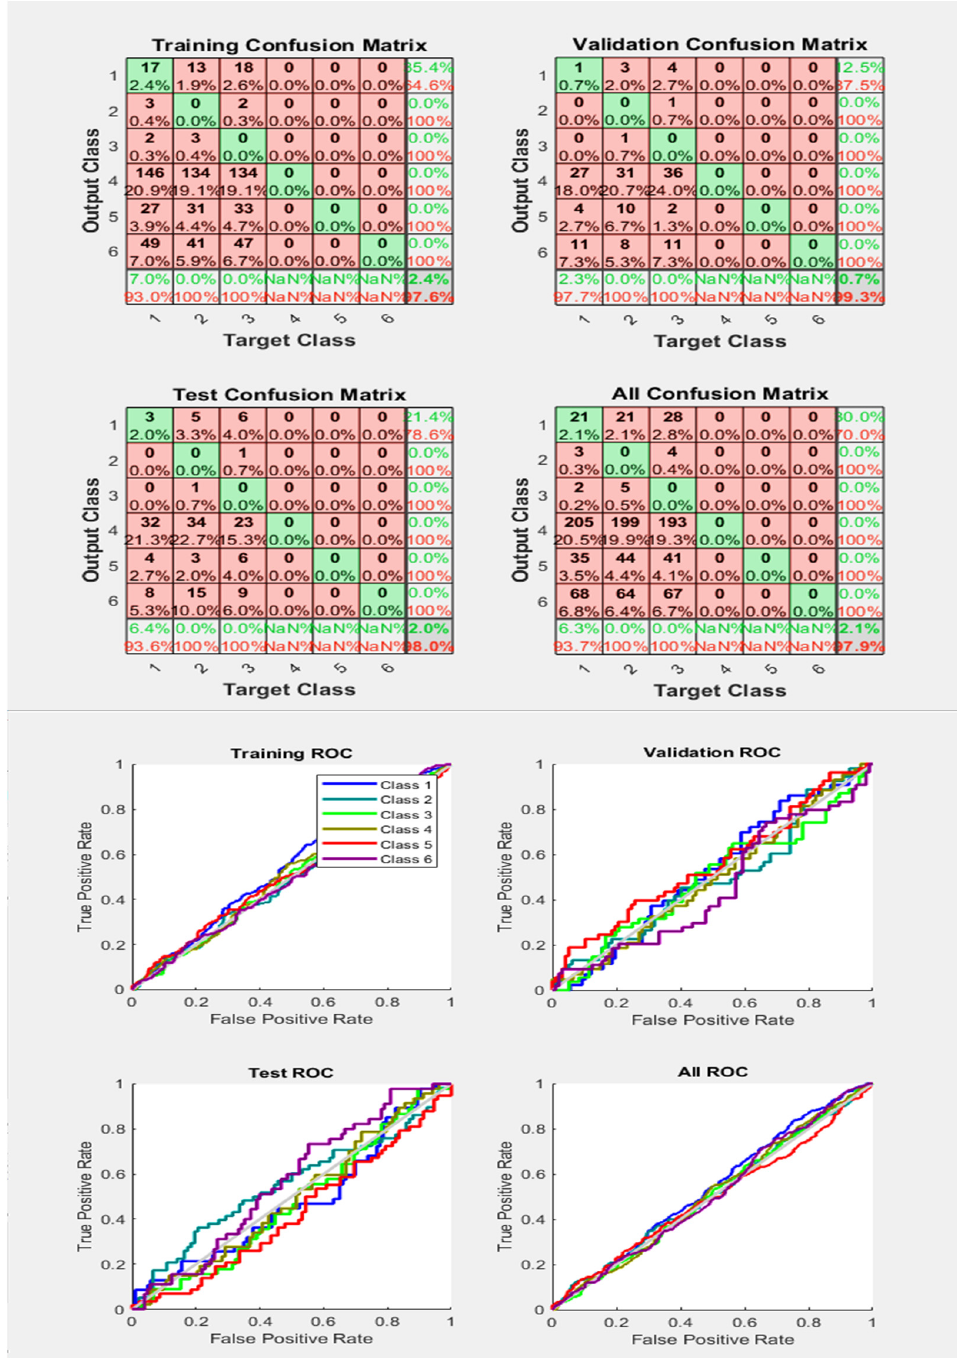
Figure 24. Neural Network Model ROC (Receiver Operating Characteristics) and Confusion Matrix for CGP TrainFcn/Activation Function at level 9 (RMS) Features for Rotor Bar Fault with 97.9% Accuracy. Grey line shows diagonal of the ROC for indicating Class 1–6 lines are lying above or below or on it.